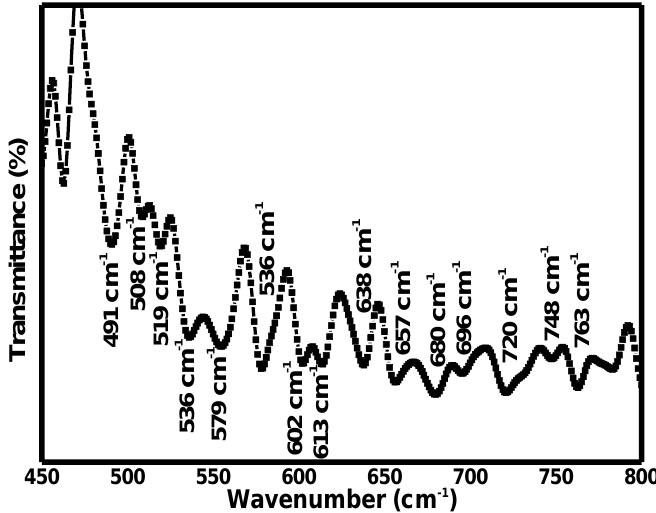
Figure 3. FTIR spectrum of Sr 2 CaTeO 6 .